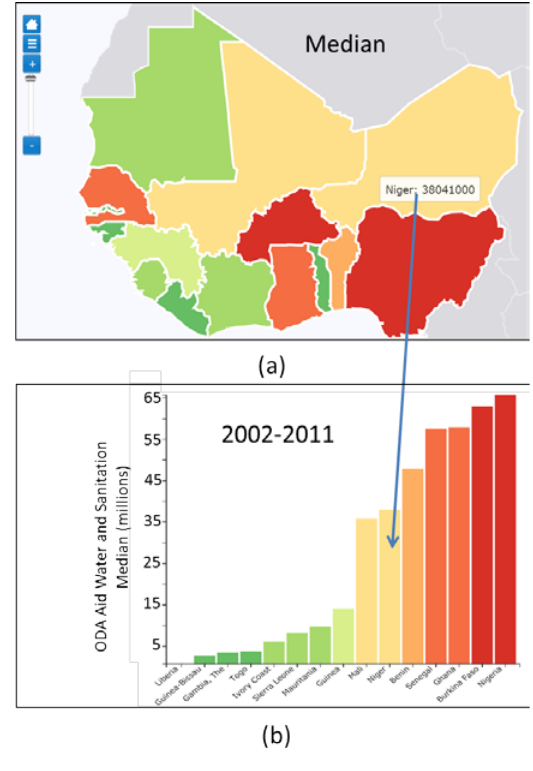
Figure 10. Summary statistics : a) map and b)